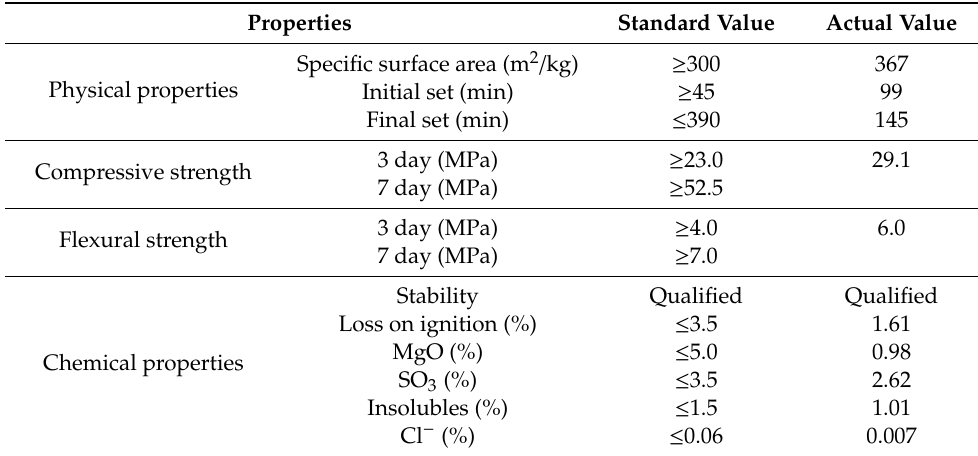
Table 1. Physical and chemical properties of cement.